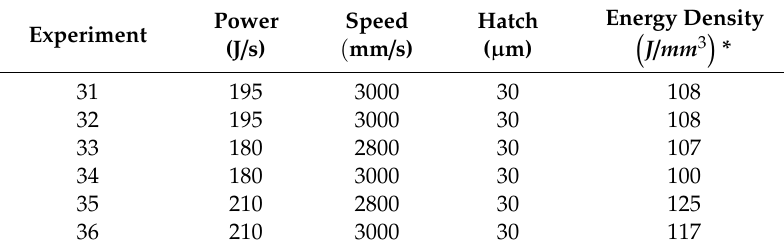
Table 4. Process parameters of the additional six samples.